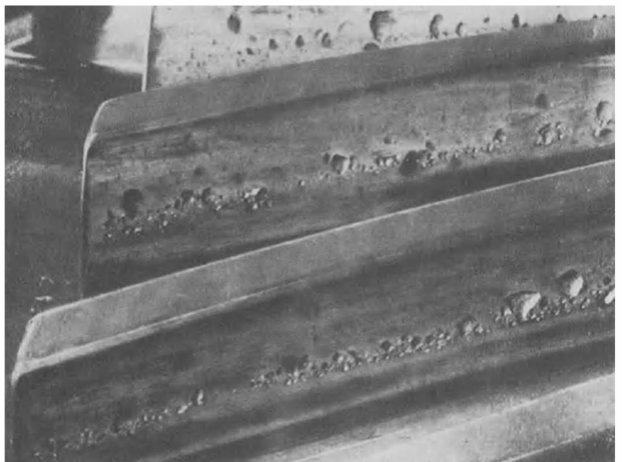
Figure 6. The initial pitting in the connection stage of a pair of teeth—2. Reprinted with permission from ref. [25]. Copyright 2002